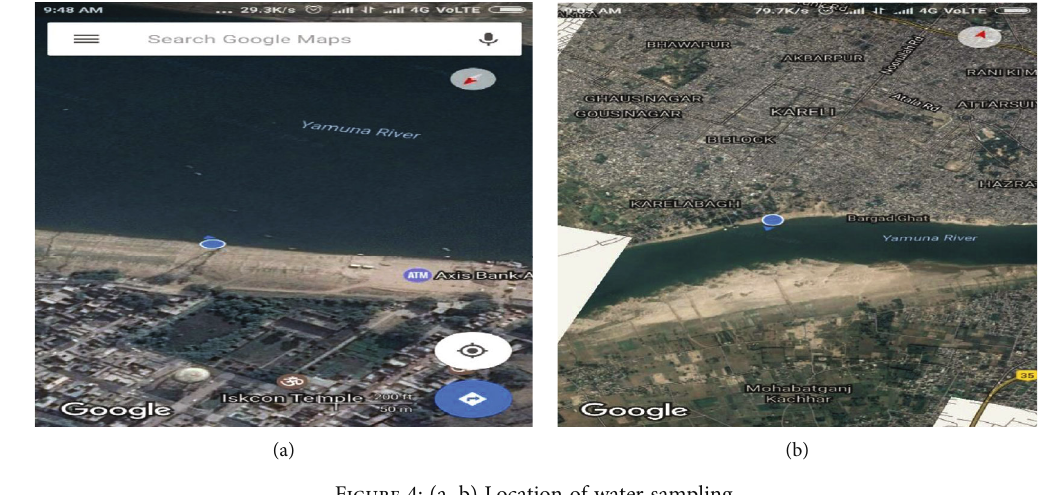
Figure 4: (a, b) Location of water